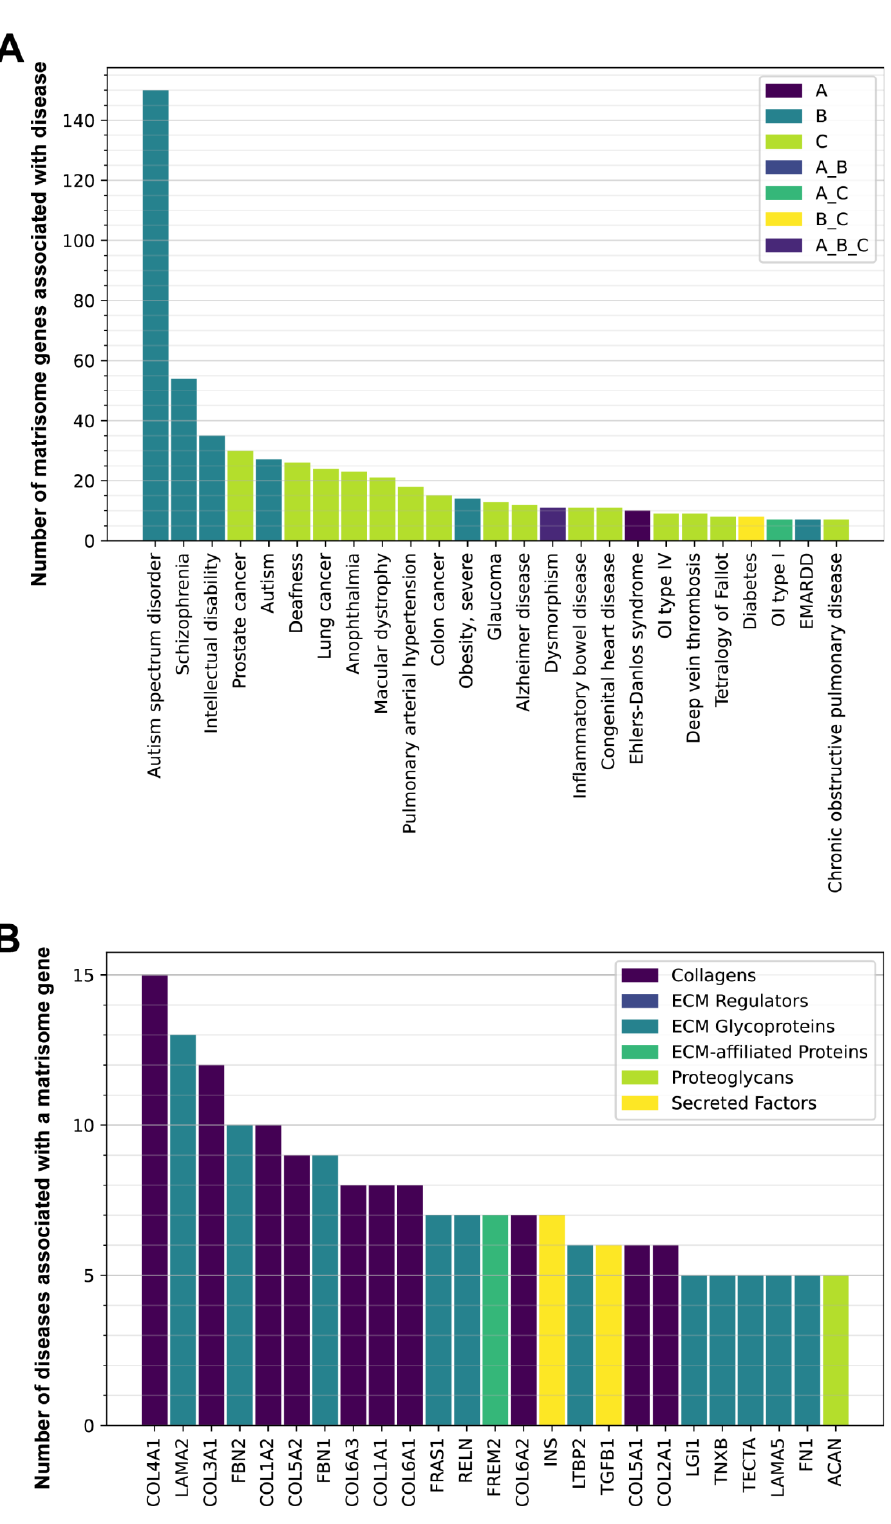
Figure 6. Matrisome-Gene–Disease Associations. Numerous diseases on the x-axis display an association with a certain number of matrisome genes on the y-axis ( A ). For example, autism- spectrum disorder, schizophrenia, and intellectual disability display the largest number of associated matrisome genes and belong to group B of diseases that would not be especially expected to correlate strongly with matrisome-related SNVs. The various matrisome genes on the x-axis ( B ) are associated with more than one displayed disease state (Supplementary Table